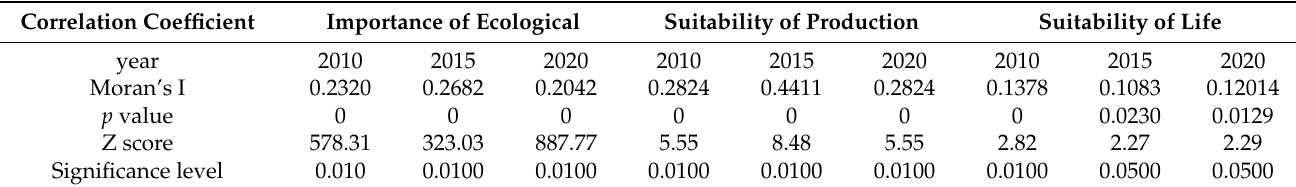
Table 3. Global autocorrelation coefficient of suitability of